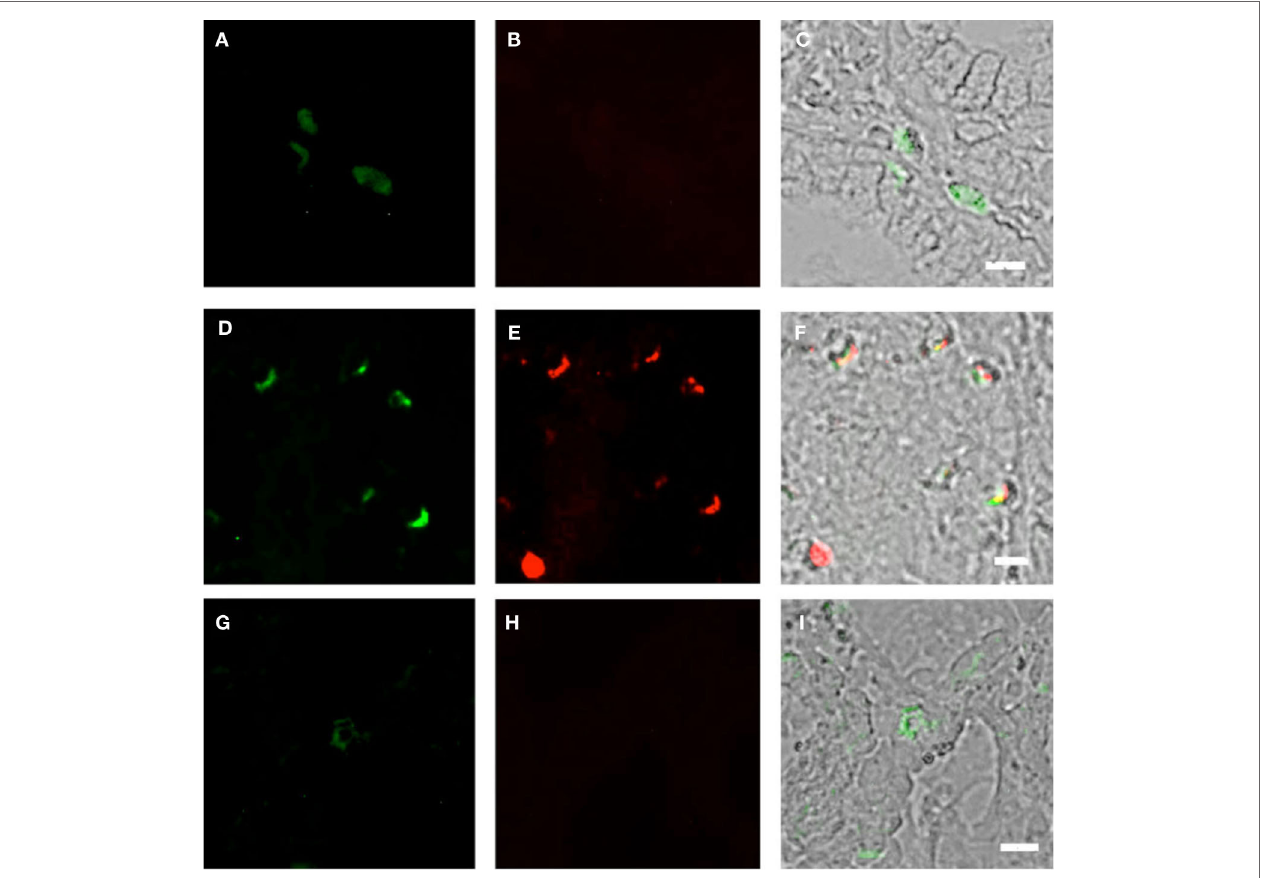
FigUre 5 | Duodenum biopsies of hiV/aiDs cases and controls evaluated for coexpression of cD303 (green) and Ki-67 (red) . Bar represents 20 μ m. (a) Control duodenum biopsies probed with a monoclonal FITC-anti-CD303 antibody. (B) Control duodenum biopsies probed with a monoclonal PE-anti-Ki-67 antibody. (c) Control duodenum biopsies DIC image merged with (D,e) . (D) HIV case duodenum biopsies probed with a monoclonal FITC-anti-CD303 antibody. (e) HIV case duodenum biopsies probed with a monoclonal PE-anti-Ki-67 antibody. (F) HIV case duodenum biopsies DIC image merged with (a,B) . (g) HIV case duodenum biopsies probed with a monoclonal FITC-anti-CD303 antibody. (h) HIV case duodenum biopsies probed with a PE-Mouse IgG1, κ isotype control antibody. (i) HIV case duodenum biopsies DIC image merged with (g,h)